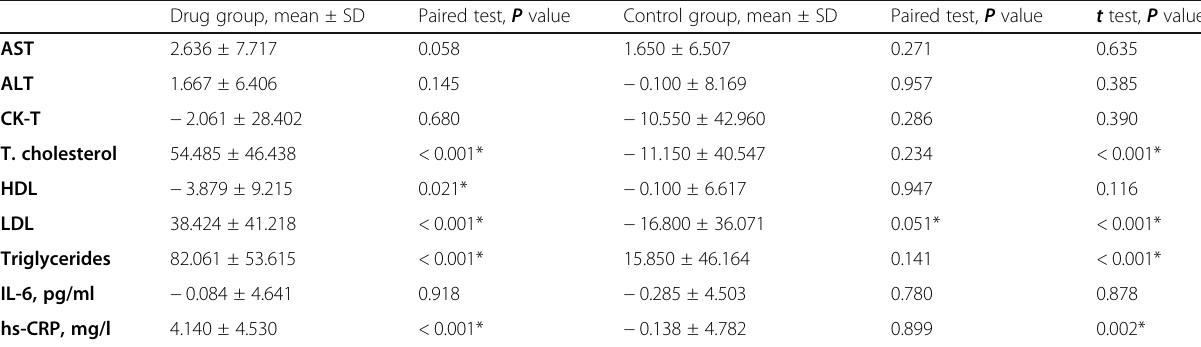
Table 3 Comparison between the drug and control groups as regards the change in the biochemical data at baseline and after 6 months Paired test, P